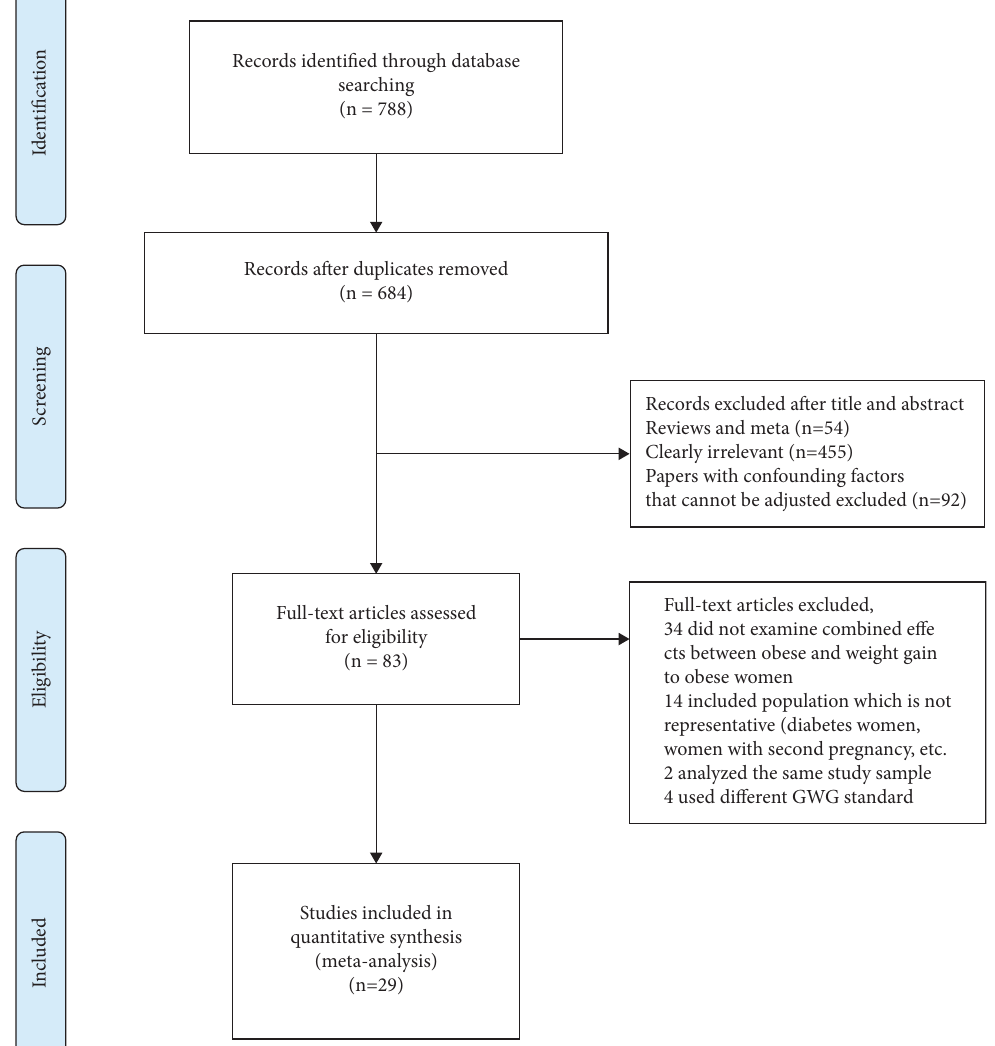
Figure 1: Flow of studies identifed and included in the current